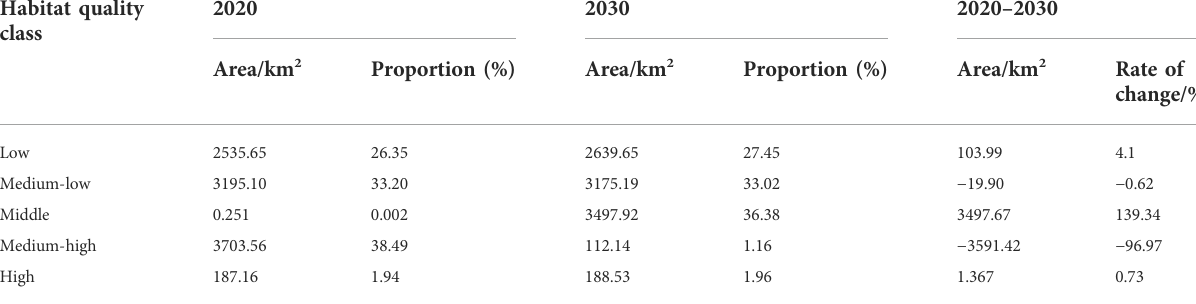
TABLE 1 Change in area and percentage of different habitat qualities in Suzhou from 2020 to 2030. Habitat quality